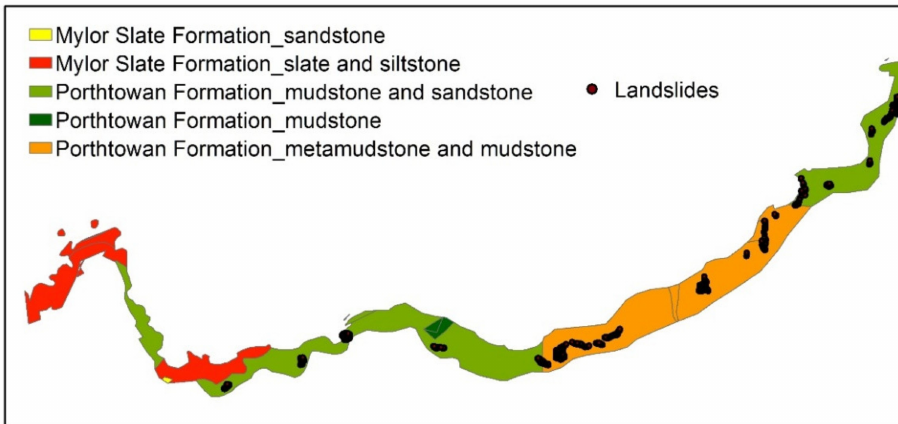
Figure 13. The component of bedrock over the study area, which is dominated by the Porthtowan Formation, with a small portion of the Mylor Slate Formation in the